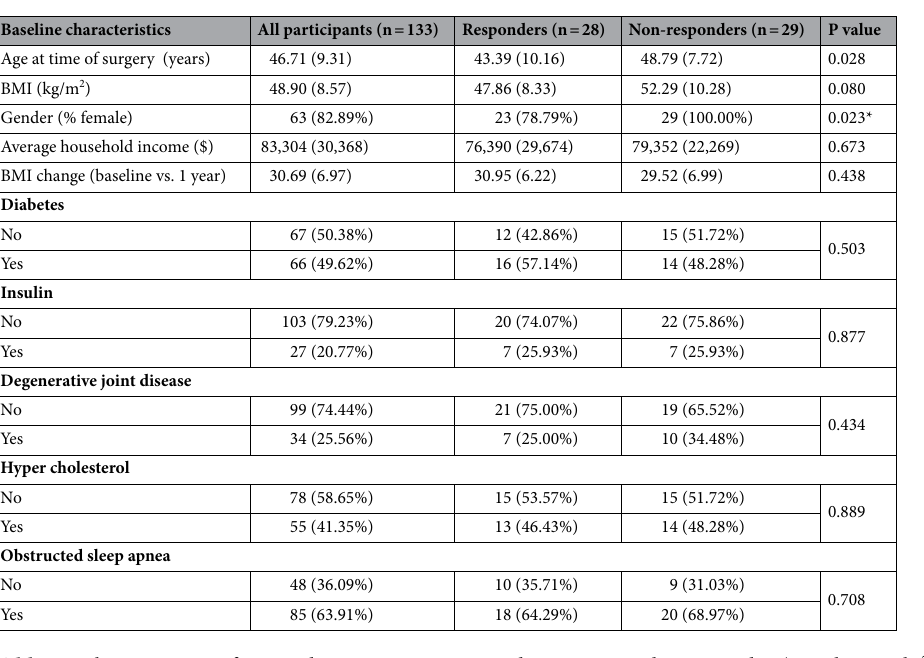
Table 6. Characteristics of responders versus non-responders. BMI = Body Mass Index (Weight/Height 2 ); Data are expressed as mean (standard deviation) if numerical variables, or as the number of patients and their percentages (%), if categorical; * Fisher Exact Test ; * Missing follow up data n = 76.